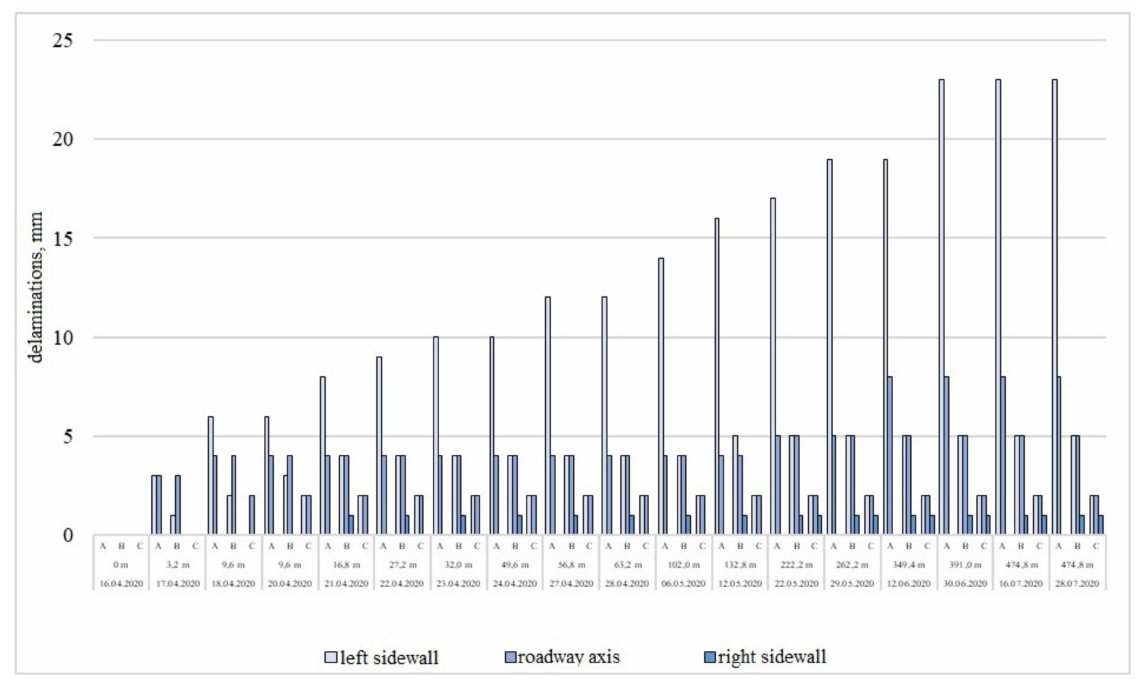
Figure 7. Roof delaminations’ values measured on the periodic control station no. 4.